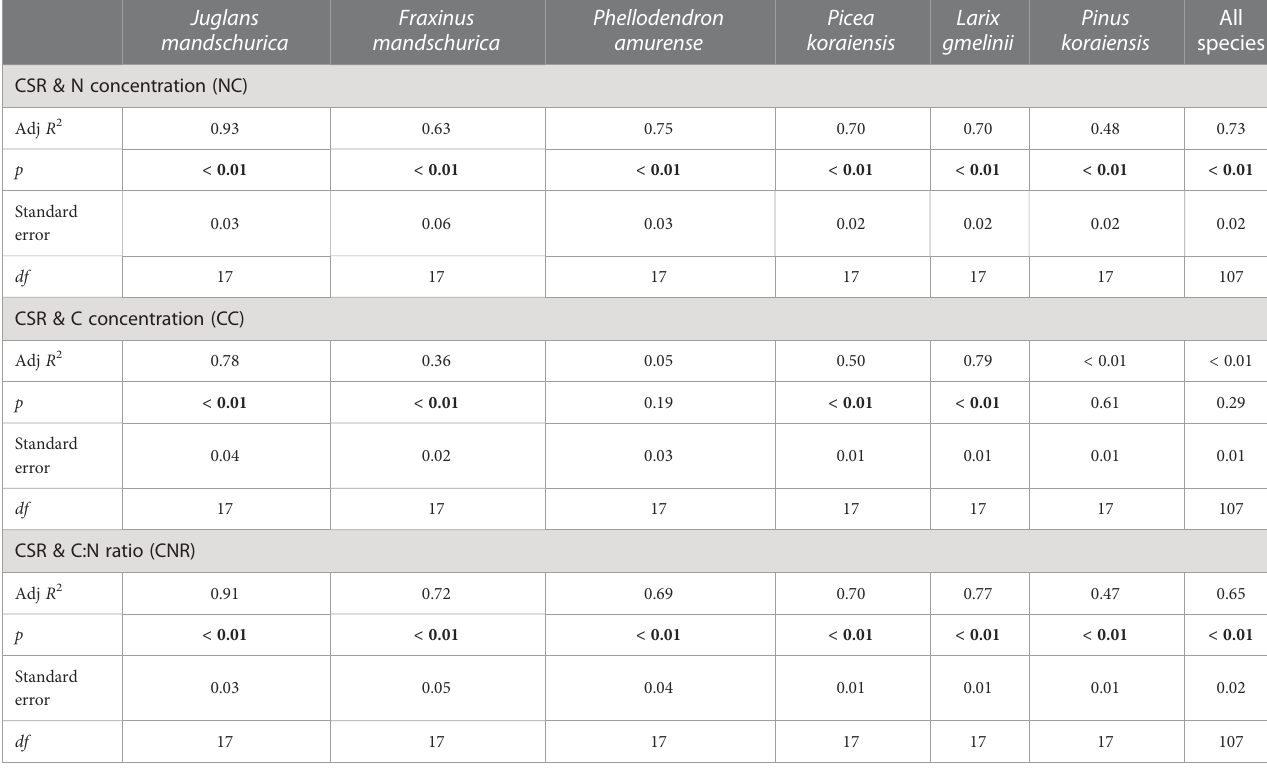
TABLE 7 Group-wise regression of the ratio of unilateral cortex thickness to stele radius (CSR) and N concentration, C concentration and C:N ratio in three angiosperms and three gymnosperms tree species. Juglans mandschurica